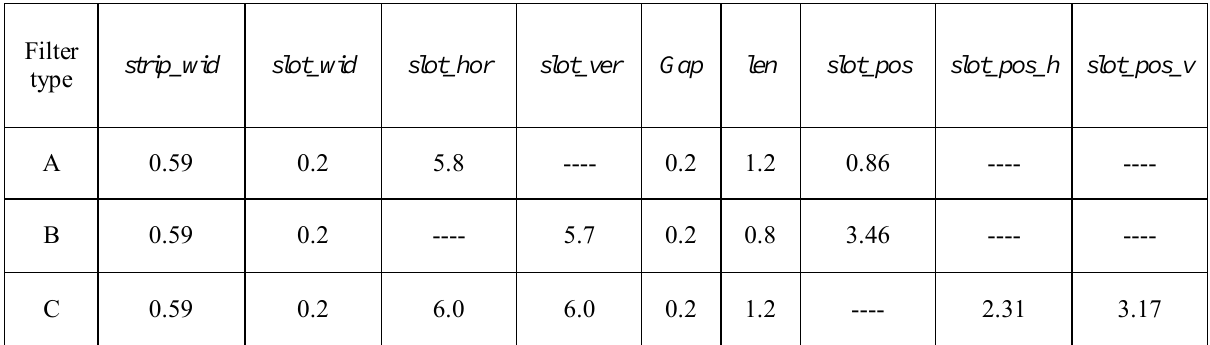
Table 1: Dimensions of the filter structures (mm).